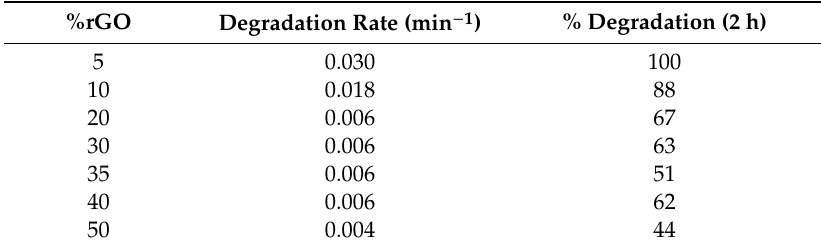
Figure 8. Kinetics of sulfamethazine (SMZ) removal by solar photodegradation in the presence of rGO/Bi composites. [SMZ] 0 = 15 mg/L. Table 4. Sulfamethazine (SMZ) degradation parameters for the different rGO/Bi composites.